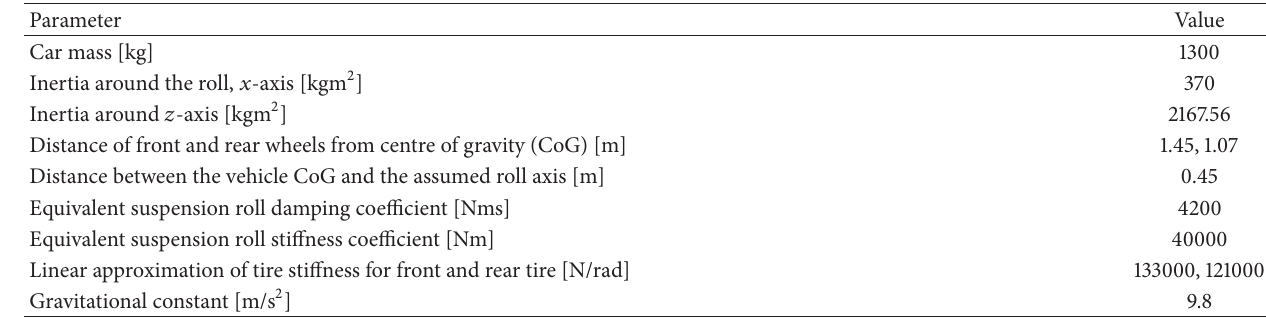
Figure 5: Force and torque for crosswind speed of 10 ms −1 . Table 1: Car vehicle